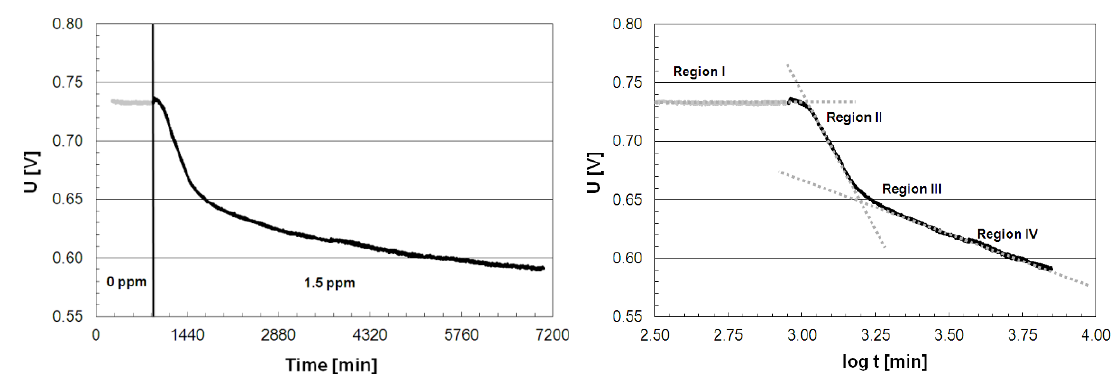
/%50N ) humidified 2 2